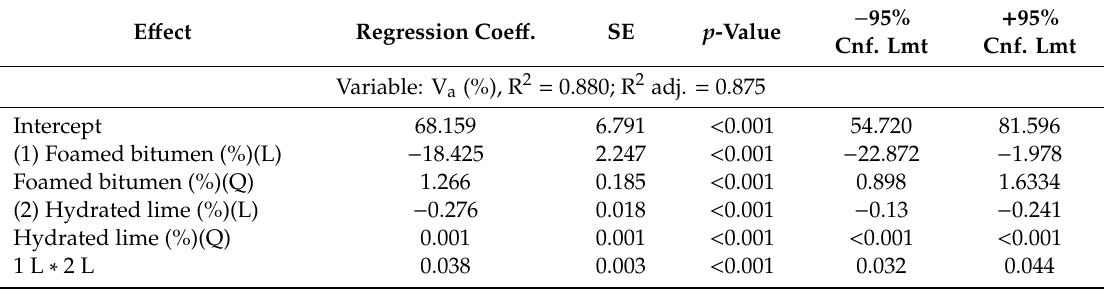
Table 5. Parameters of the model describing the relationships between V a of AC 8 S and the contents of foamed bitumen with 0.6% SAA and hydrated lime. E ff ect